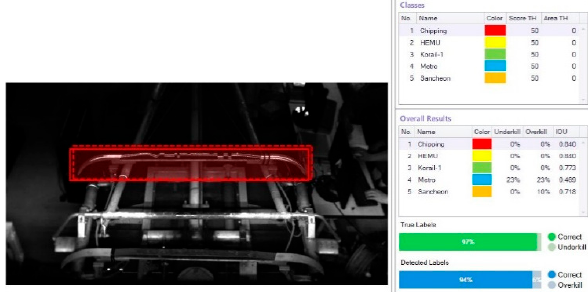
Figure 9. Basic flow chart of CNN (ConvNet).